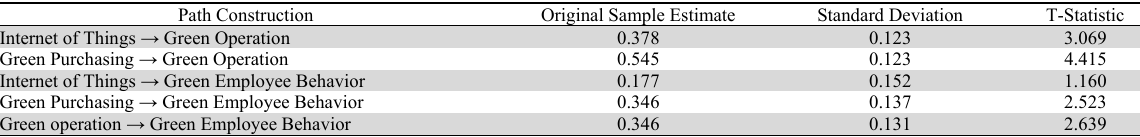
Inner Model Tests for Direct Effect Assessment Path